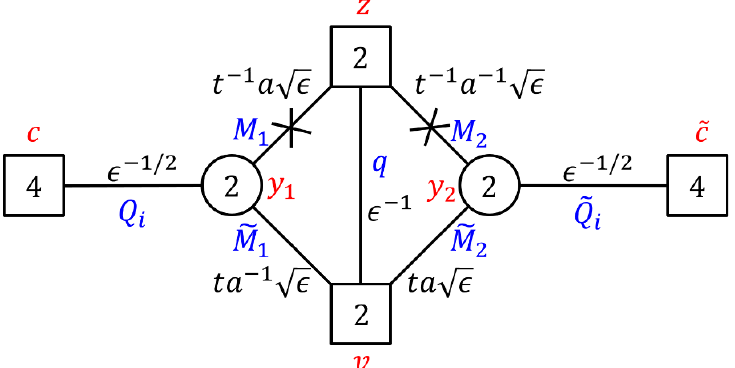
Figure 3 . A quiver diagram of a trinion with three maximal punctures for rank one E-string. The squares and circles denote SU( n ) global and gauge symmetries, respectively, where n is the number inside the shapes. All (cid:12)elds have R-charge 1 = 2 except the gauge singlet (cid:12)elds that have R-charge 1. (cid:15) is the fugacity associated to the additional maximal puncture, while t , a and the two SU(4)’s are related to the internal symmetries that arise from 6 d . In blue we write the (cid:12)eld names, in red we write the symmetries associated fugacities, and in black we write the charges of each (cid:12)eld. The X ’s on bifundamental (cid:12)elds denote (cid:13)ip (cid:12)elds coupled through the superpotential to baryonic operators built from the bifundamentals. Six additional (cid:13)ip (cid:12)elds need to be included as well, three (cid:13)ipping half of the six operators in the symmetric representation of each of the SU(4)’s. These break each of the two SU(4) symmetries to SU(3) (cid:2) U(1). In addition, each triangle has a superpotential term turned on for